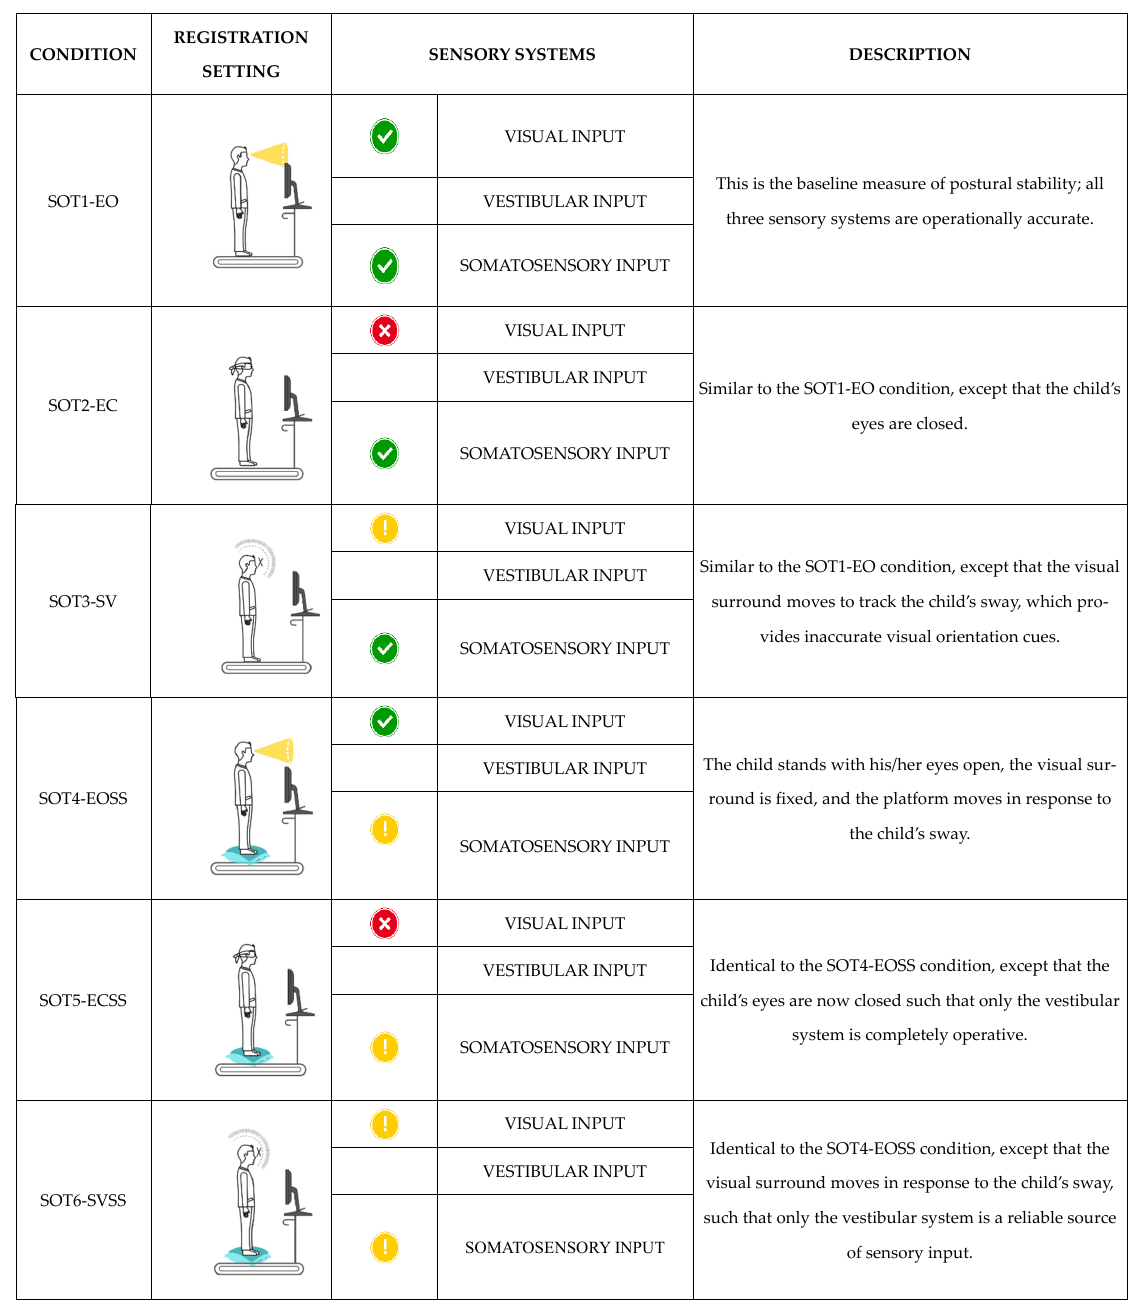
Figure 1. SOT: Sensory Organization Test; EO: Eyes Open; EC: Eyes Closed; SV: Sway-referenced Vision; EOSS: Eyes Open Sway-referenced Support; ECSS: Eyes Closed Sway-referenced Support; SVSS: Sway-referenced Vision Sway-referenced Support. Visual input is the sensation of any change in the visual environment. Vestibular input is the sensation of any change in position, direction, or movement of the head. Somatosensory input is the sensation of any change in, but not limited to, touch, temperature, posture, and limb position.